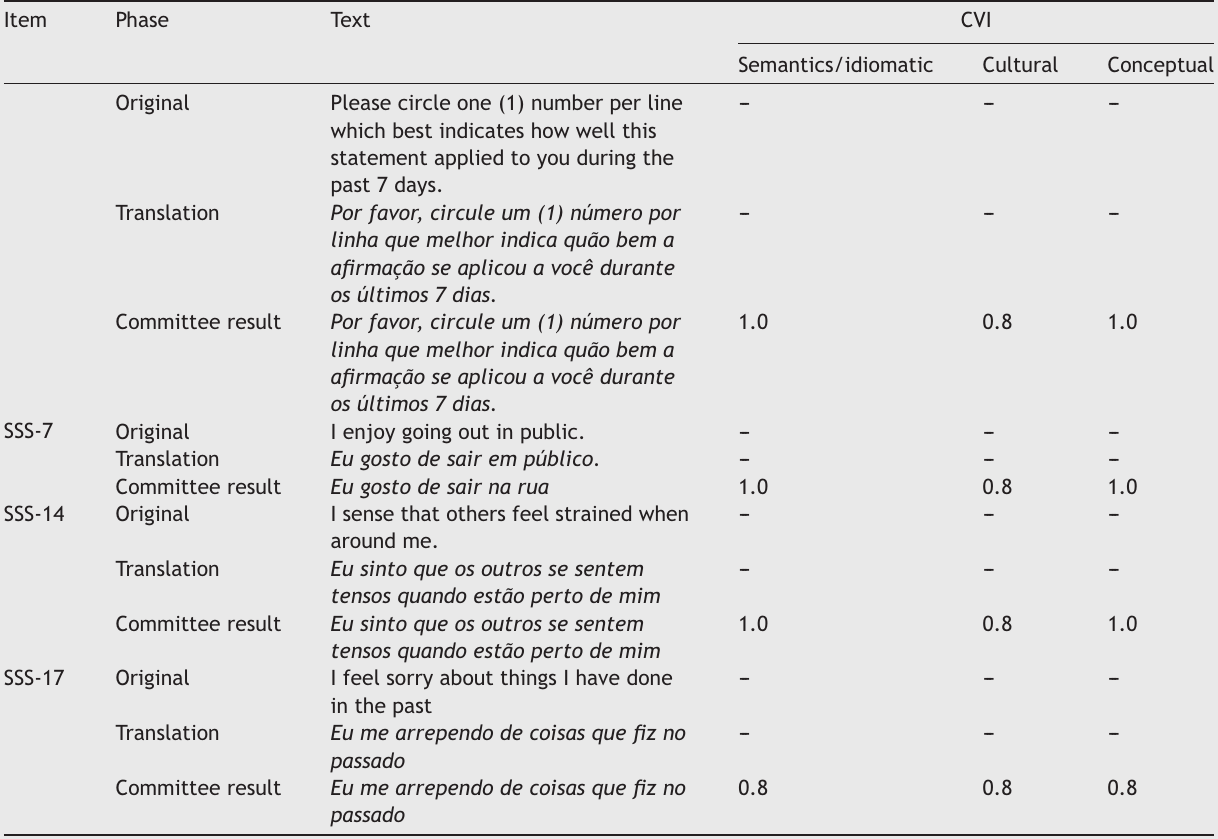
Items of the scale that had CVI scores =